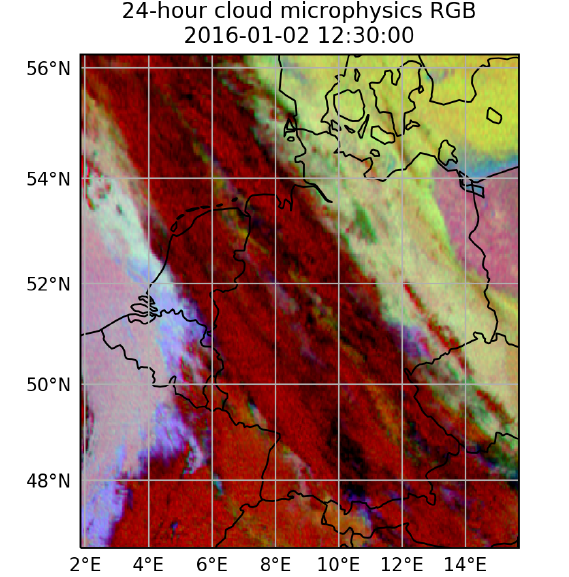
Figure 1. The 24 h cloud microphysics RGB image made from the 8.7, 10.8, and 12.0 µ m channels spanning our studied area, i.e., Belgium, the Netherlands and Germany. This image allows distinguishing of different microphysical properties of the clouds. The red component relates to cloud optical thickness, the green component relates to cloud particle size and the blue component relates to the cloud top temperature. Red colors in the RGB indicates thick cold clouds with large particles, which are likely to produce